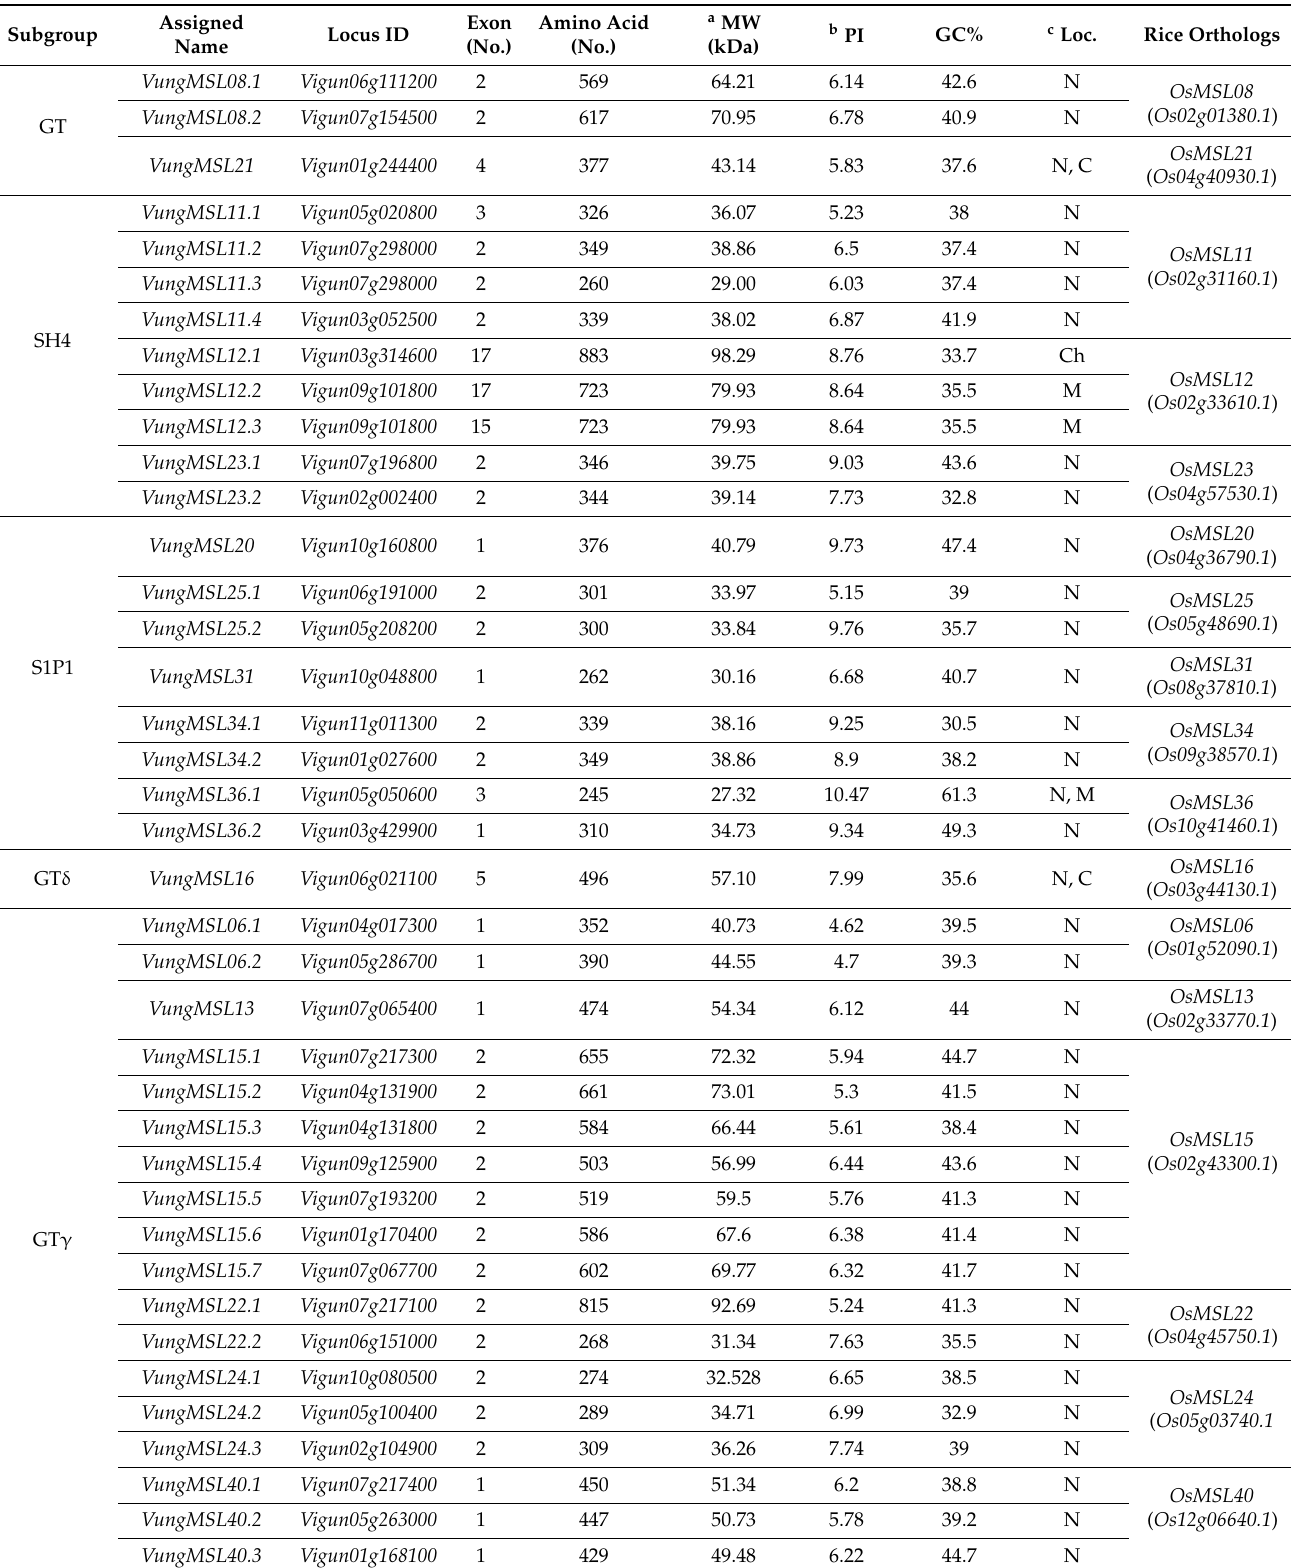
Table 1. Basic characteristics of Cowpea ( Vigna unguiculata ) Trihelix